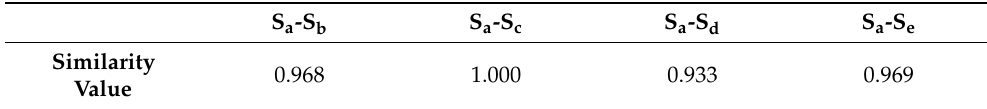
Table 19. Geometric similarity values between each scene and query